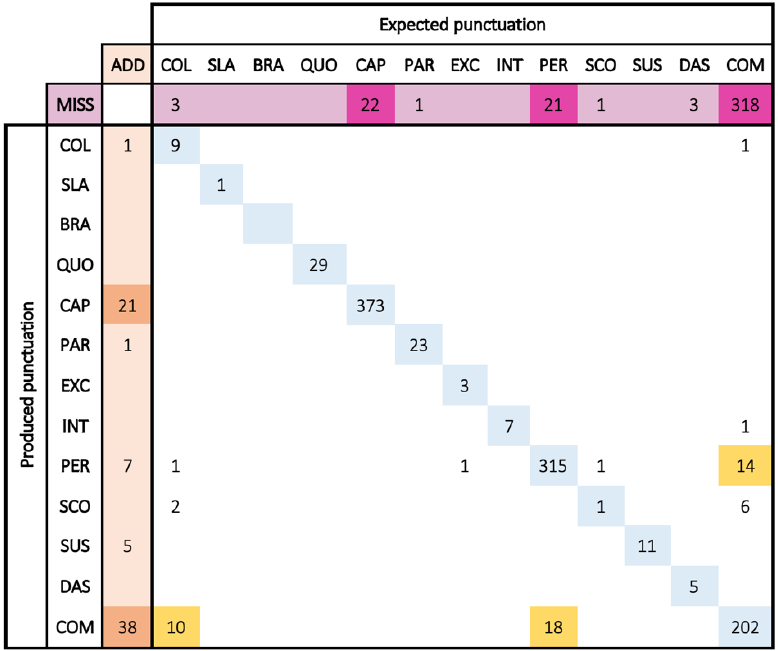
Figure 2. Dyslexic group confusion matrix: in rows, how much each symbol was produced (or missed); in columns, how many times it was expected (or added) (see Section 5.2.1 for interpretation guidelines).